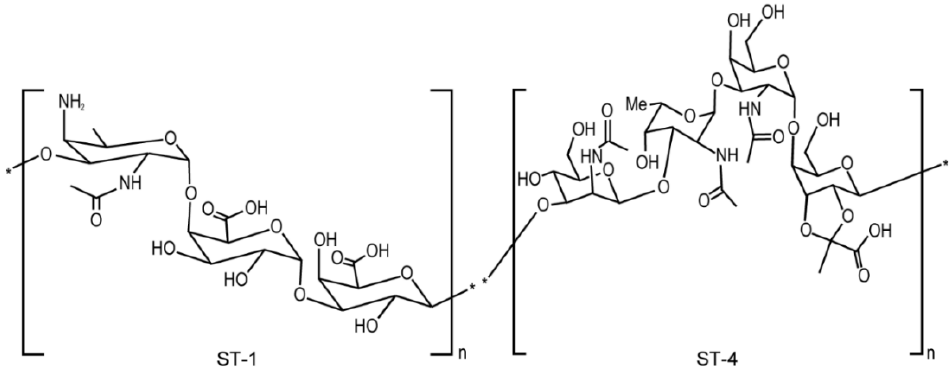
Figure 2. Structure of pneumococcal ST-1 and ST-4 polysaccharides.